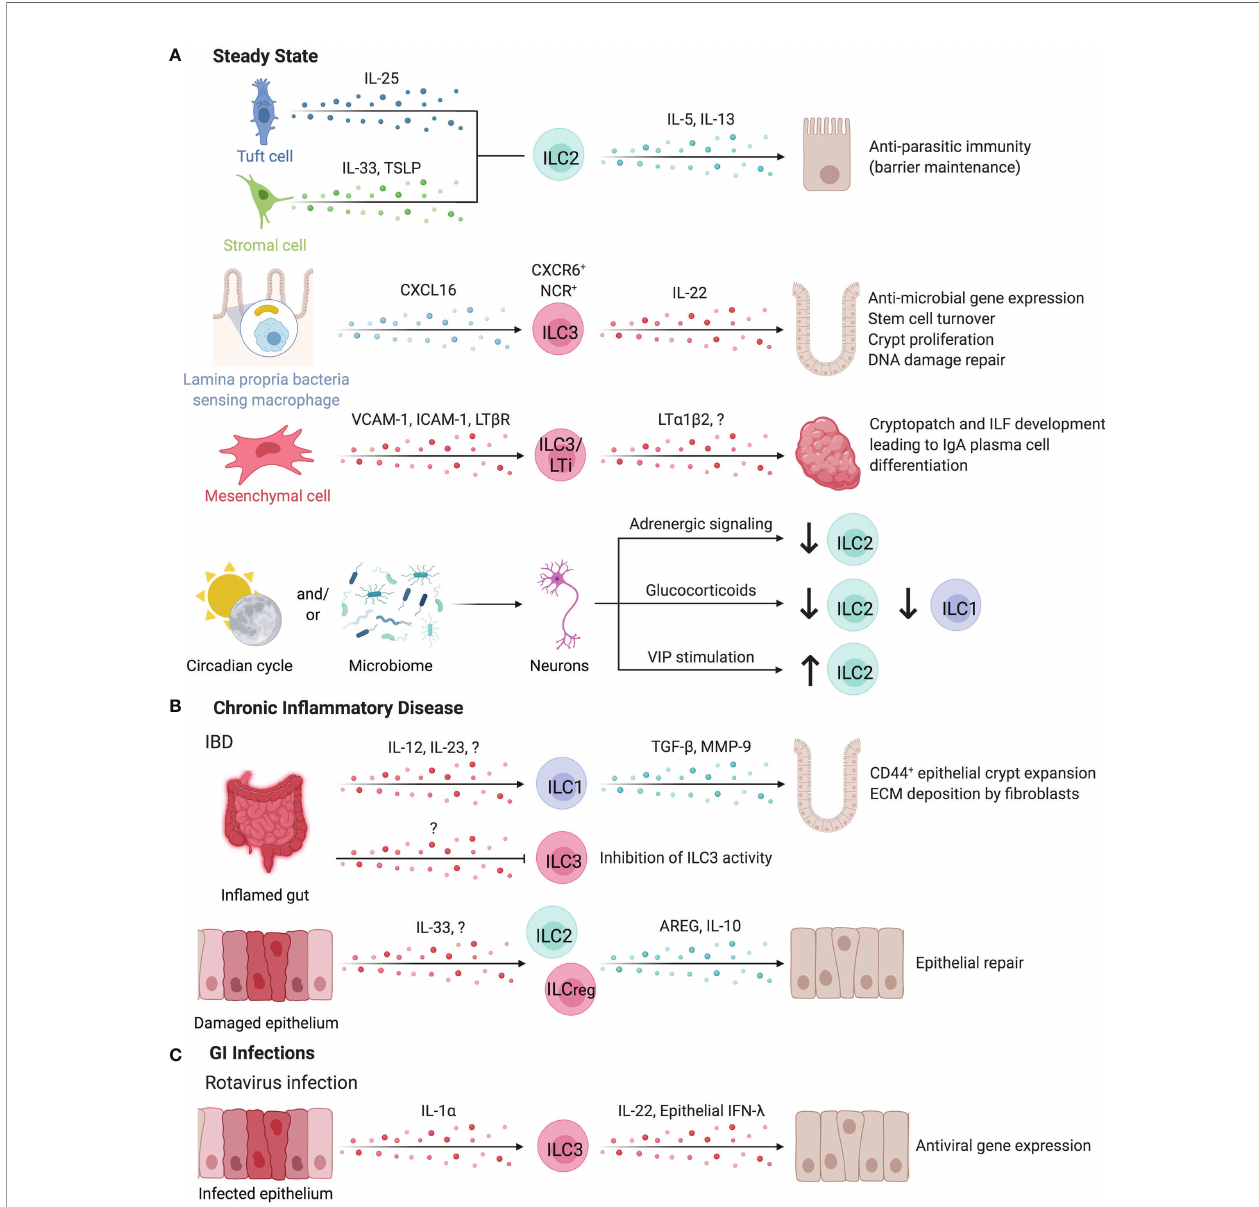
FIGURE 6 | ILCs in the intestines. ILCs have important roles in maintaining intestinal homeostasis (A) . ILC2s can be activated by both IL-25-producing tuft cells or IL-33 and TSLP-secreting stromal cells to promote anti-parasitic immunity in the intestines. ILC2s secrete IL-5 and IL-13 to promote host defense through parasite expulsion. Similarly, microbiota-sensing CX3CR1 + macrophages position IL-22-secreting CXCR6 + NCR + ILC3s in the lamina propria via CXCL16. IL-22 supports anti-microbial gene expression in Paneth cells and promotes stem cell turnover, crypt proliferation, and DNA damage repair. Interaction of ILC3/LTi surface LT a 1 b 2 and LTBR on mesenchymal cells leads to the upregulation of VCAM-1 and ICAM-1, resulting in the formation of cryptopatches and ILF. These tertiary lymphoid structures support the differentiation of IgA-producing plasma cells to promote barrier defense and host-microbiota mutualism. Clock genes and circadian cycles, modulated through feeding and the microbiota drive important homeostatic neuro-immune interactions in the gut. Disruption of circadian regulation alters ILC3 function, abundance, and traf fi cking into the intestines while negatively regulating ILC2s through adrenergic signaling. Glucocorticoids or vasoactive intestinal peptide further control ILC1 and ILC2 responses. (B) In chronic in fl ammatory disease such as intestinal bowel disease (IBD), the in fl amed gut induced TGF- b and Matrix metalloproteinase 9 production by ILC1s leading to the expansion of epithelial crypt cells and extracellular matrix deposition by fi broblasts, exacerbating fi brosis. In contrast, pro-tolerogenic ILC3 functions including the release of GM-CSF, IL-2 or the expression of MHC-II are impaired in IBD patients, suggesting an anti- in fl ammatory role for ILC3s. IL-10 producing regulatory ILC2s or ILCregs may also suppress intestinal in fl ammation. (C) Enteric infection by Rotavirus induces epithelial-derived IL-1 a to promote ILC3 production of IL-22, which synergizes with epithelial IFN- l to promote the induction of antiviral responses in intestinal epithelial cells. Created with